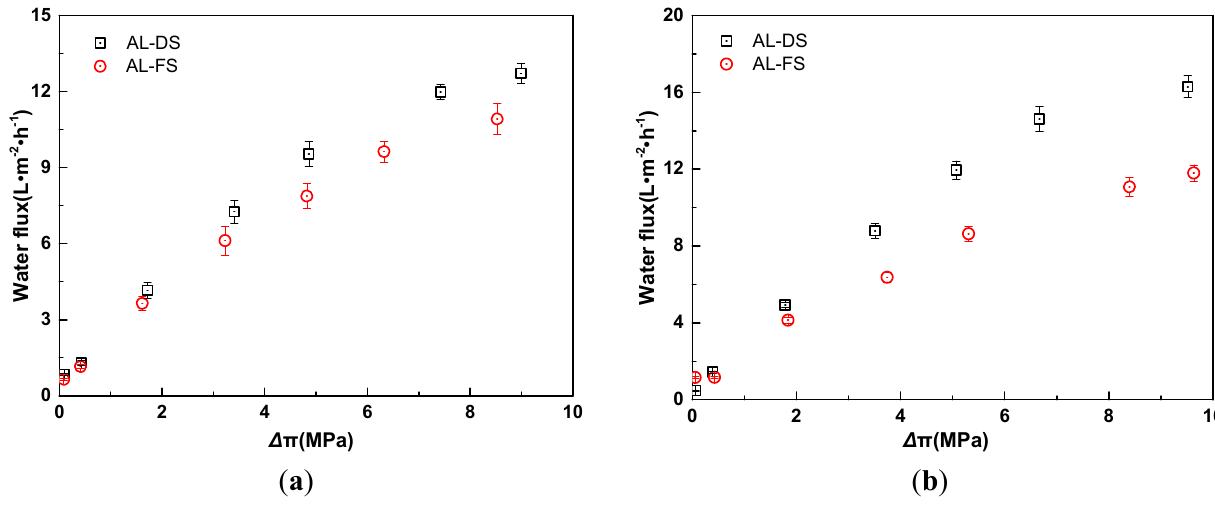
Figure 1. Relationship of water flux and osmotic pressure difference in two membrane orientations for KCl as draw solute ( t = 25 °C). AL-DS: active layer facing the draw solution; AL-FS: active layer facing the feed solution. ( a ) C osmotic pressure difference refers to the effective values after correction for the effect of external concentration polarization